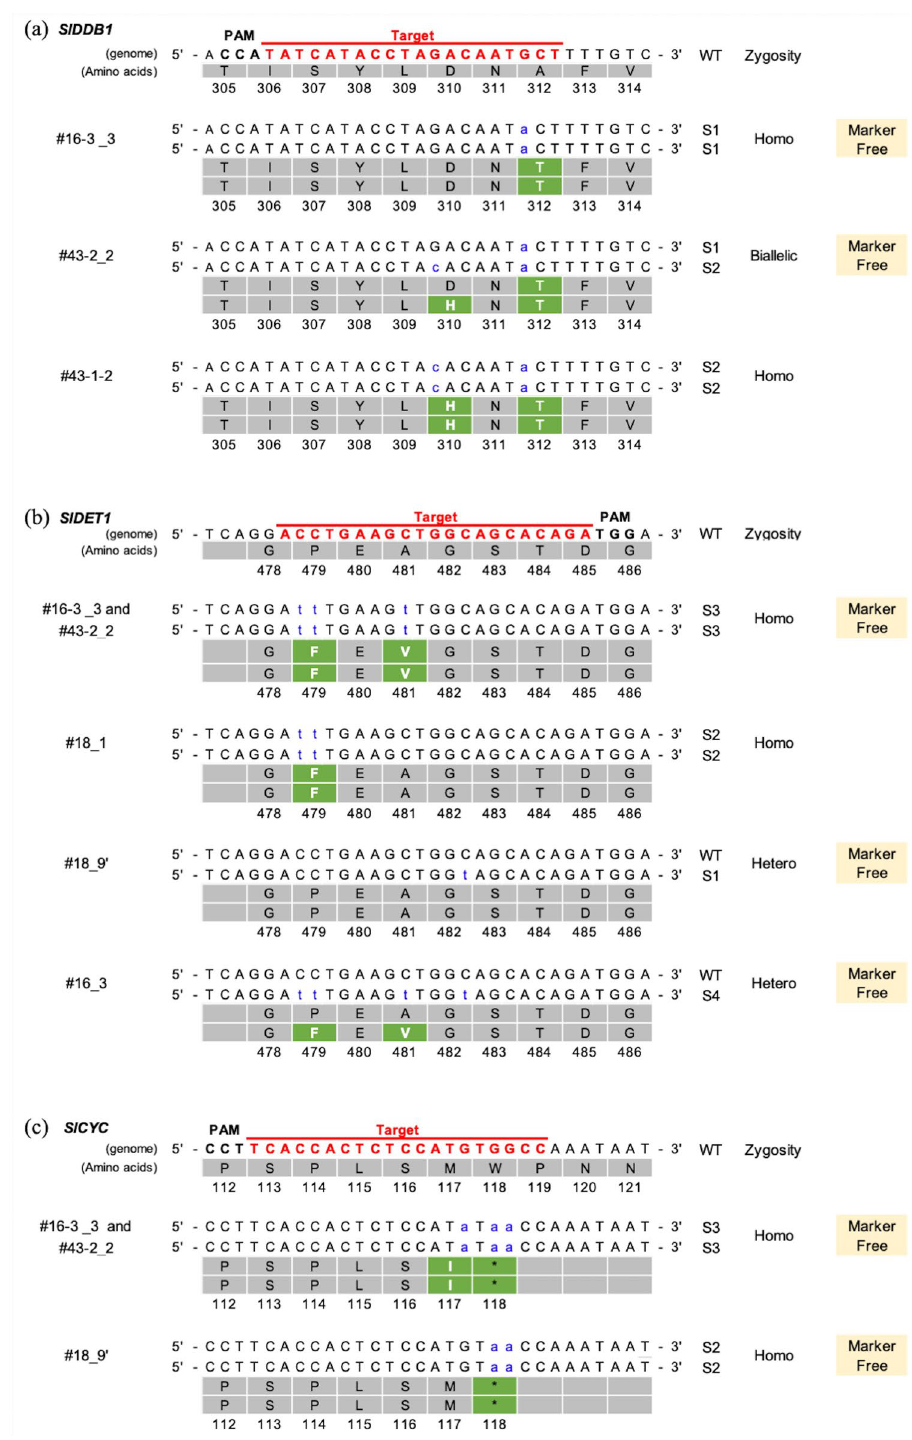
Figure 4. Target AID vectors induce nucleotide and amino acid substitutions in gene-edited tomato plants. Representative substitution spectra and changes in amino acid residues in T 1 plants. All figures show target sequences, PAM sequences and DNA modifications are in bold red, bold black, and bold blue font, respectively. Numbers under amino acid sequence represent the residue number position in the protein sequence. ( a ) Changes in amino acid residues in DDB1-targeted T 1 plants; ( b ) changes in amino acid residues in DET1- targeted T 1 plants. ( c ) Changes in amino acid residues in CYC-B-targeted T 1 plants. ‘S’ followed by a number correspond to substitution, with the number of nucleotides substituted. The substitutions in amino acid residues were due to the corresponding DNA substitutions in T 1 plants. The marker gene-free plants are